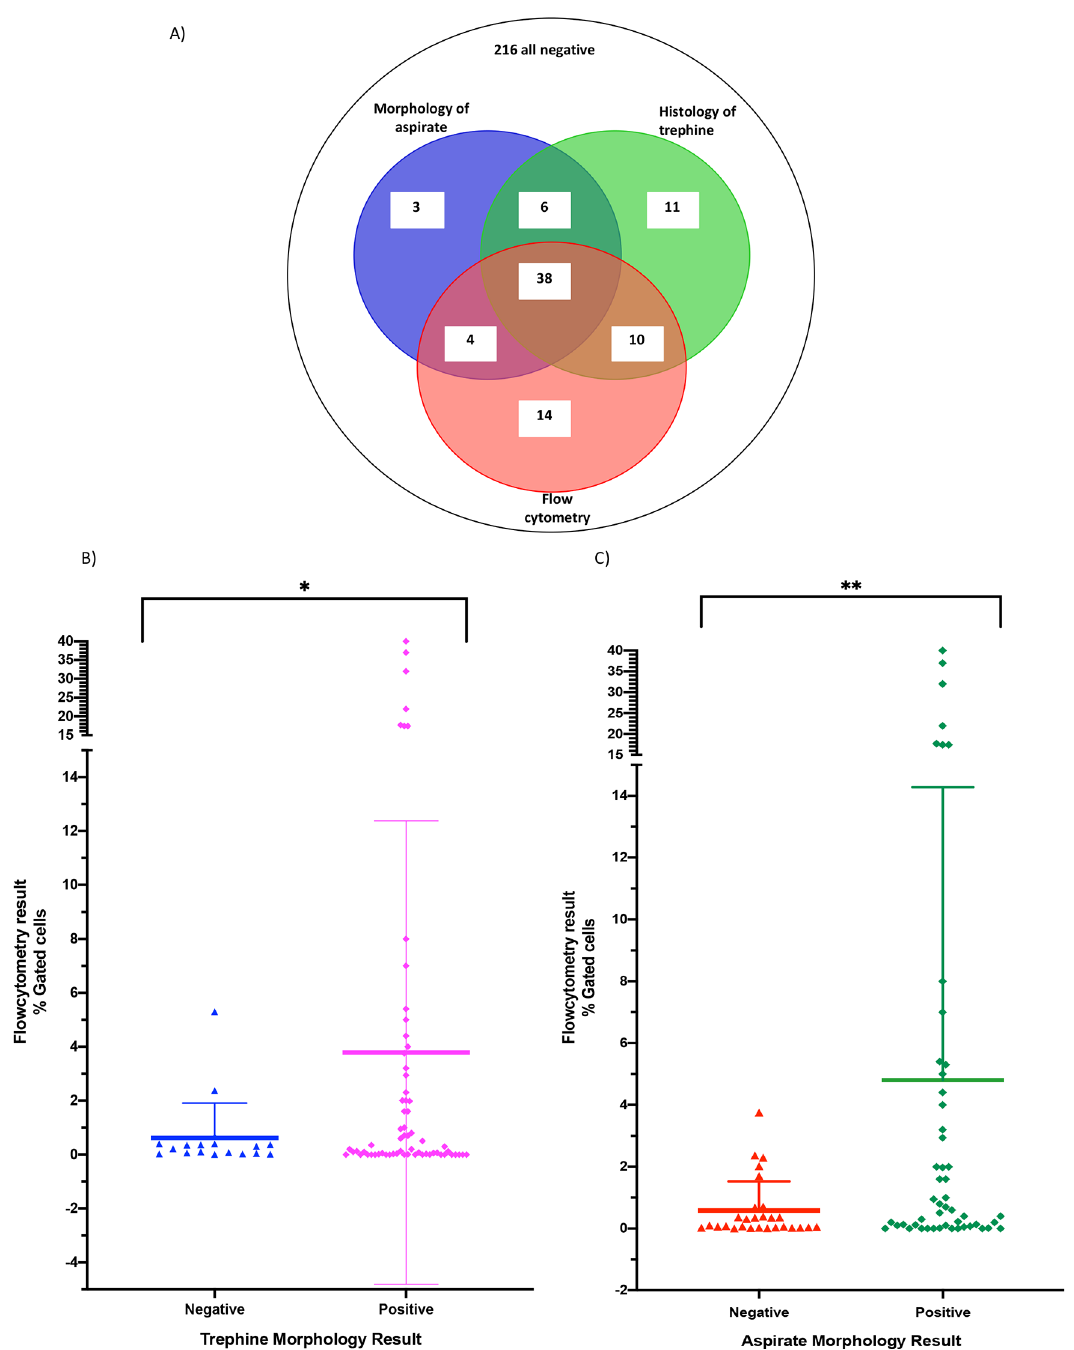
Figure 2. Comparison of positive results by flow cytometry, cytology and immunohistochemistry. A) Venn diagram of all positive cases. B) Negative trephine results in blue, positive trephine results in pink. 216 negative samples by all modalities excluded from analysis. Box and whisker plot showing the Mean and standard deviation of results *p-value 0.0056 by Welch ’ s t-test. C) Negative cytology results in red, positive cytology results in green. 216negativesamplesbyallmodalitiesexcludedfromanalysis.BoxandwhiskerplotshowingtheMeanandstandard deviation of results, **p-value 0.0027 by Welch ’ s